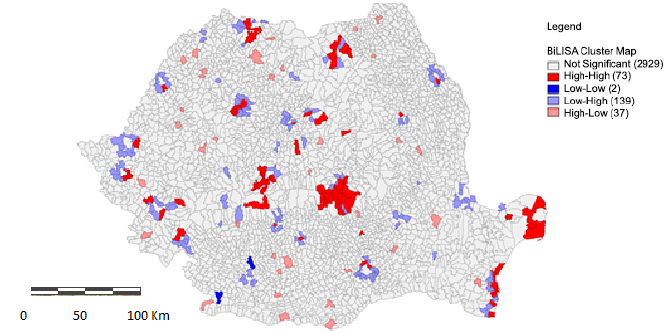
Figure 10: Categories of significant spatial associations of LAUs for the cross-correlation between the number of accommodation companies and the number of foodservice compa-